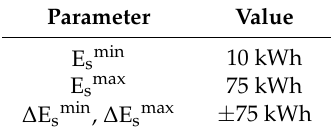
Table 3. Parameters of the Energy Storage System (ESS).